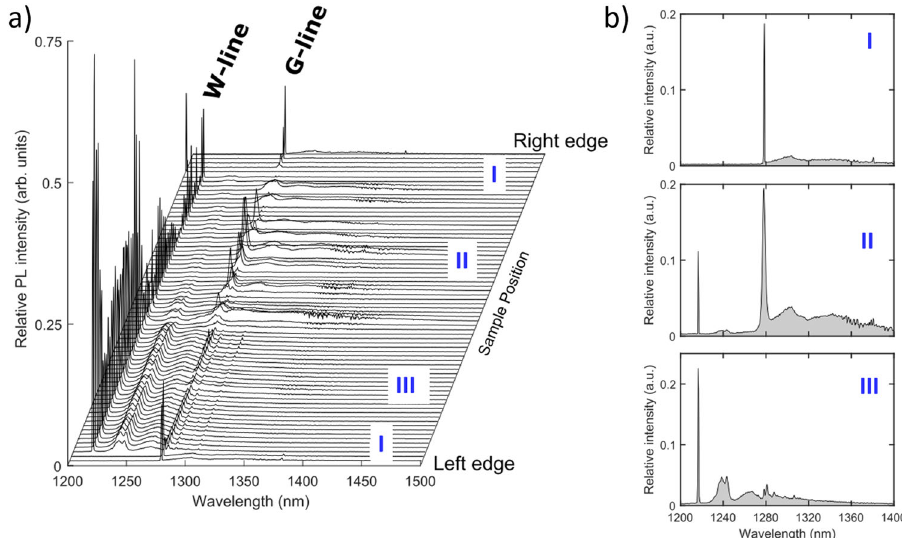
Fig. 8 Photoluminescence (PL) spectra across a sample after exposure to laser-ion pulses. a Line scan of low temperature (3 K) Photoluminescence (PL) spectra taken across a silicon (111) sample that had been exposed to two laser-ion pulses. b Spectra from the left and right edge of the sample where we observe only G-centers, corresponding to the area labeled (I) in the optical microscope image shown in Fig. 2. Areas with increased ion fl ux show both W and G-centers, corresponding to area (II) in Fig. 2. Regions with higher local ion fl ux show mostly W-centers, (III) in Fig. 2.